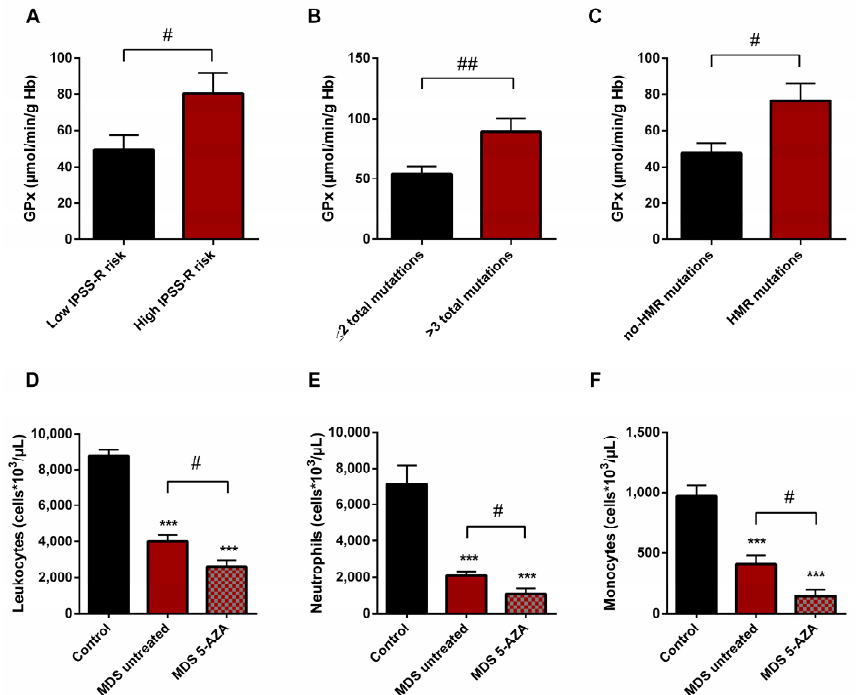
Figure 5. Risk prognostic factors and leucocyte populations in MDS patients. GPx activity in untreated MDS patients according to ( A ) IPSS-R score, ( B ) mutational score and ( C ) molecular risk. ( D ) Leucocyte populations, ( E ) neutrophils and ( F ) monocytes in untreated MDS patients and 5-AZA group. # p < 0.05, ## p < 0.01; *** p < 0.001 vs. control.